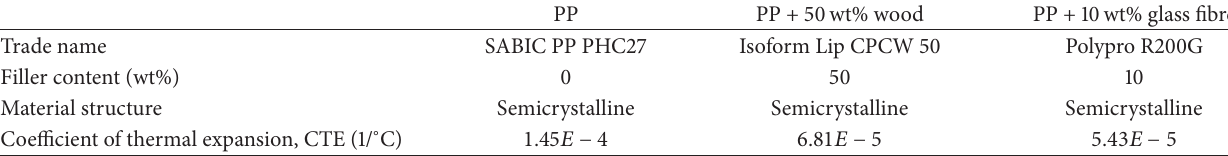
Table 2: The material properties of PP, PP + 50 wt% wood, and PP + 10wt% glass fibre.